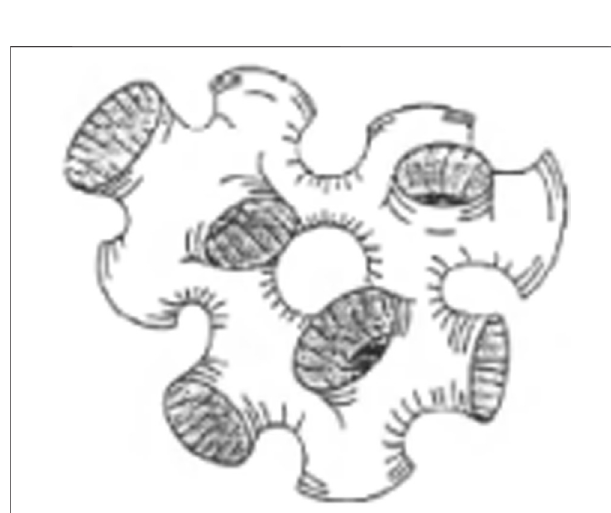
FIGURE 3 | Schematic diagram of random connected bilayer network (Schuster, 1996).